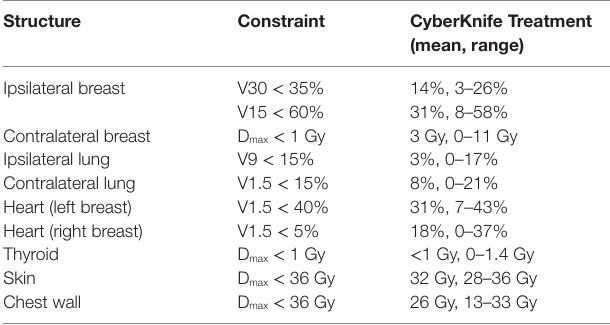
TaBle 2 | Dose limitations for normal tissue based on the nsaBP/rTOg B-39 protocol for patients treated with cyberKnife saPBi to a total dose of 30 gy delivered in five fractions ( n =